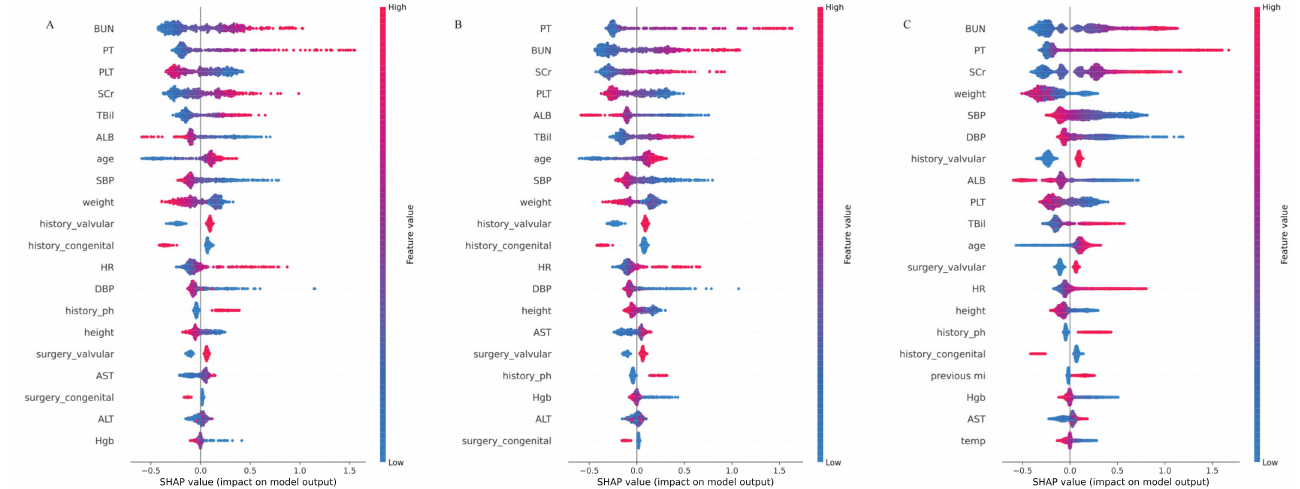
Figure 4. The higher the SHAP value of a feature, the higher the probability of postoperative AKI development ( X -axis is for the SHAP values, and the Y -axis is for the important features. Red represents higher feature values for positive influence, and blue represents lower feature values for negative impact). ( A ) The top 20 features of the CatBoostClassifier model in the development dataset by the SHAP model explainer. ( B ) The top 20 features of the CatBoostClassifier model in the validation dataset by the SHAP model explainer. ( C ) The top 20 features of the CatBoostClassifier model in the MIMIC-IV dataset by the SHAP model